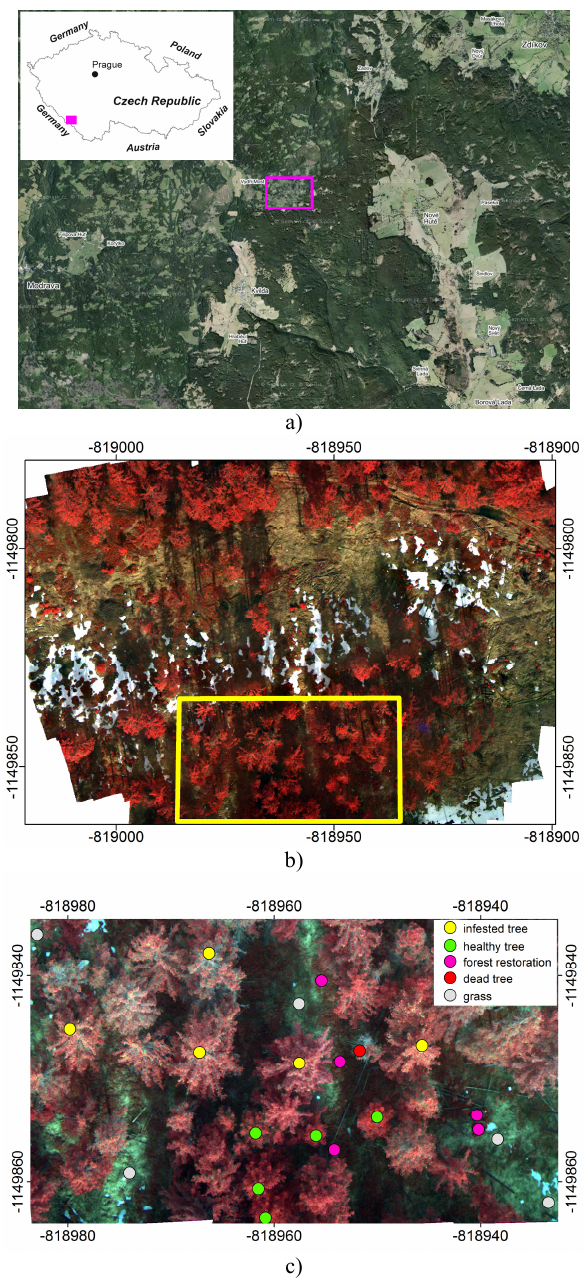
Figure 1. Study area. a) Study region with marked Forest Infrared Index, b) Study site, where UAV imaging was performed, c) Research plot, analysed in this